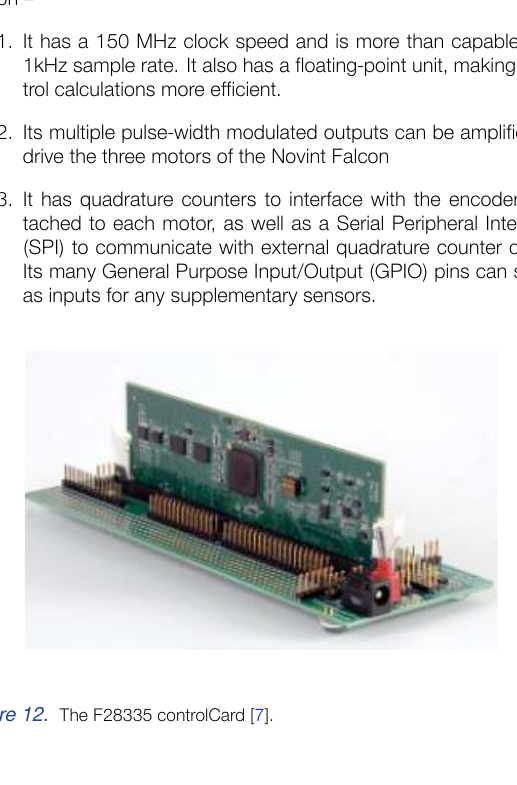
Figure 11: Schematic of the LS7366R Quadrature Counter [10] Figure 14. Schematic of the LS7366R Quadrature Counter The quadrature encoder channels A and B are connected to the A and B pins, respectively (pins 12 and 11). The SPI bus is serviced on the SS, SCK, MISO, and MOSI pins (pins 4, 5, 6, and 7).